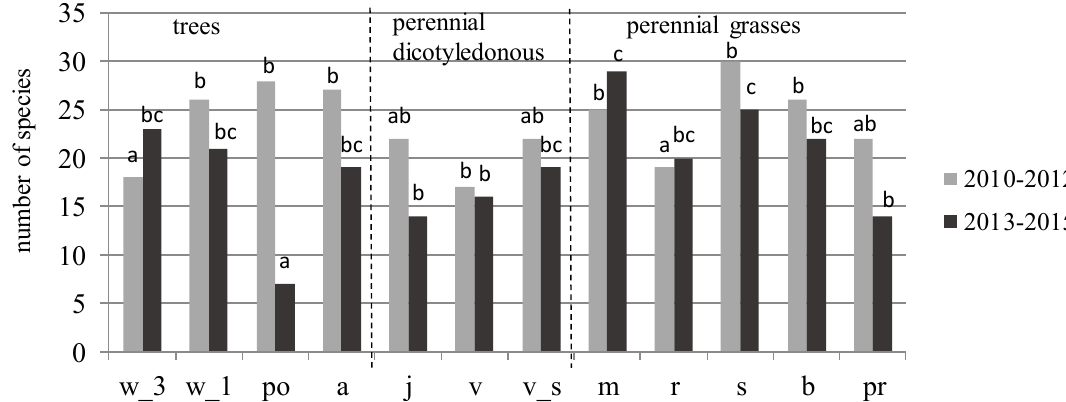
Figure 2. Weed species richness on energy crop plantations in 2010–2012 and 2013–2015. Means for the three years are presented in each column ( n = 3). Within each dataset, different letters represent significantly different values according to the Kruskal ‒ Wallis test ( p ≤ 0.05). Explanation of symbols: